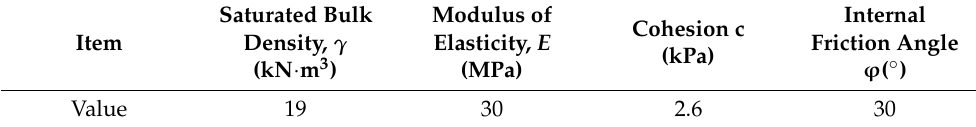
Figure 2. Soil numerical model. Table 2. Soil parameters.